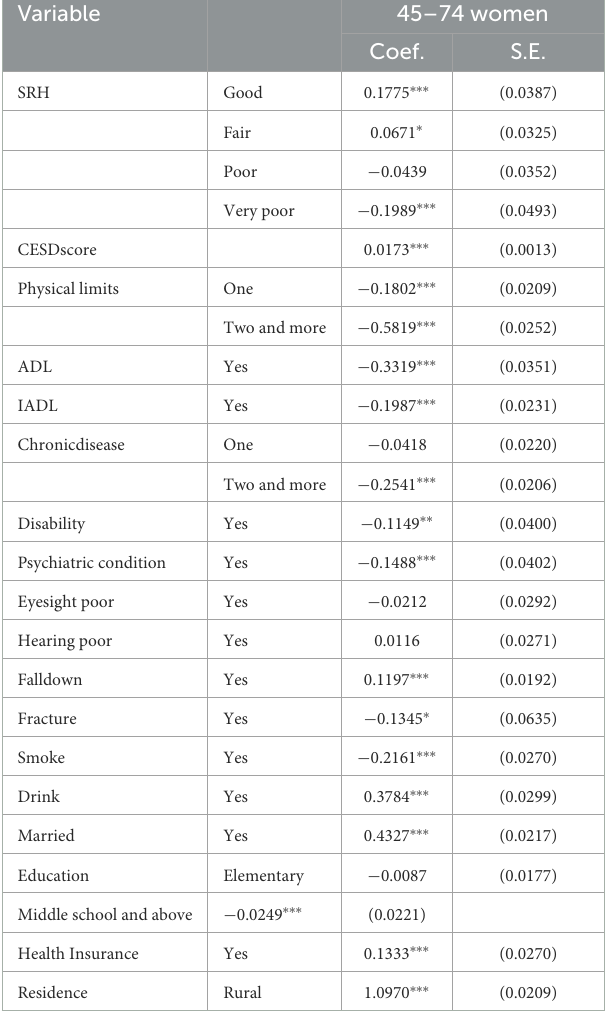
TABLE 2 Regression of women’s health and labor participation ( N =